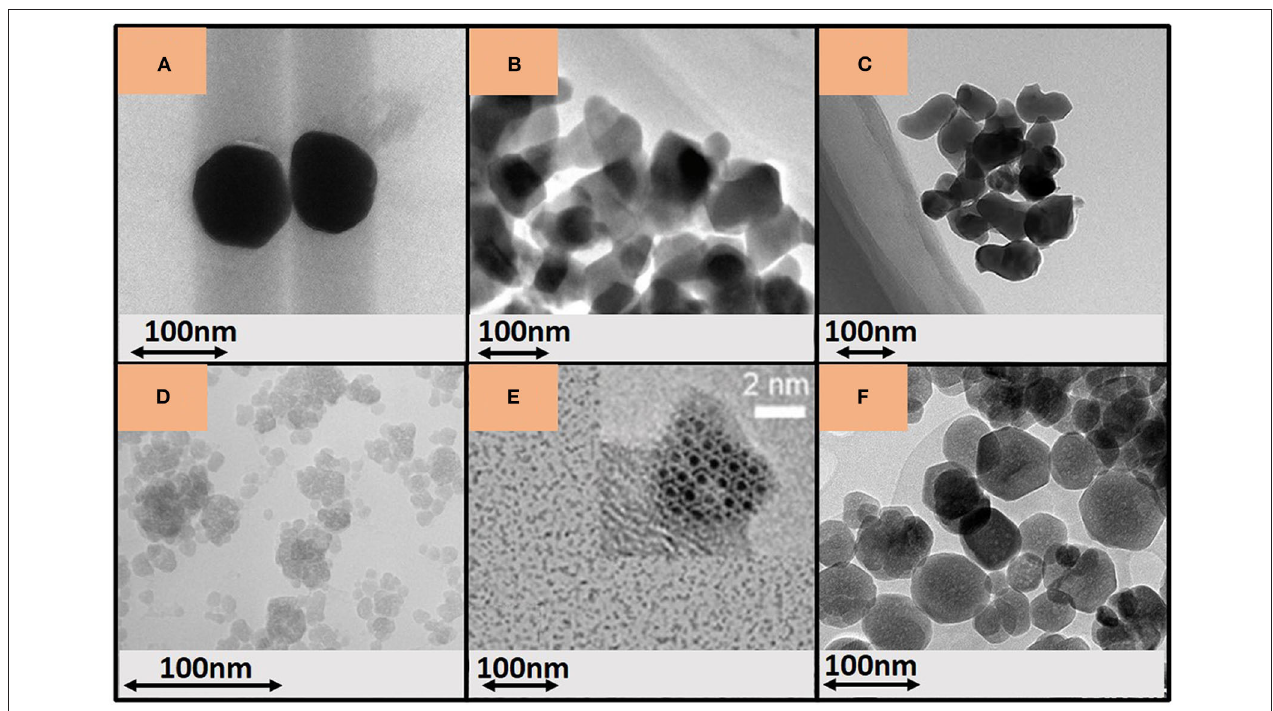
FIGURE 1 | Microscopy images of YAG:Ce NCs prepared (A) by combustion, reproduced from Abd et al. (2019), with permission from the authors; (B) by co-precipitation, reproduced from Si et al. (2014), under the Creative Commons CC BY license; (C) by modified Péchini method, reproduced from He (2016), under the Creative Commons CC BY license; (D) by conventional solvothermal synthesis. Image reproduced from Kasuya et al. (2005), with permission from American Chemical Society, Copyright (2020); (E) by solvothermal synthesis after precursor dehydration and adding diethylene glycol. Image reproduced from Odziomek et al. (2017) , with permission from The Royal Society of Chemistry; (F) by modified solvothermal synthesis, high pressure, and steady high temperature. Image reproduced from Dantelle et al. (2018a), under the Creative Commons CC BY license.